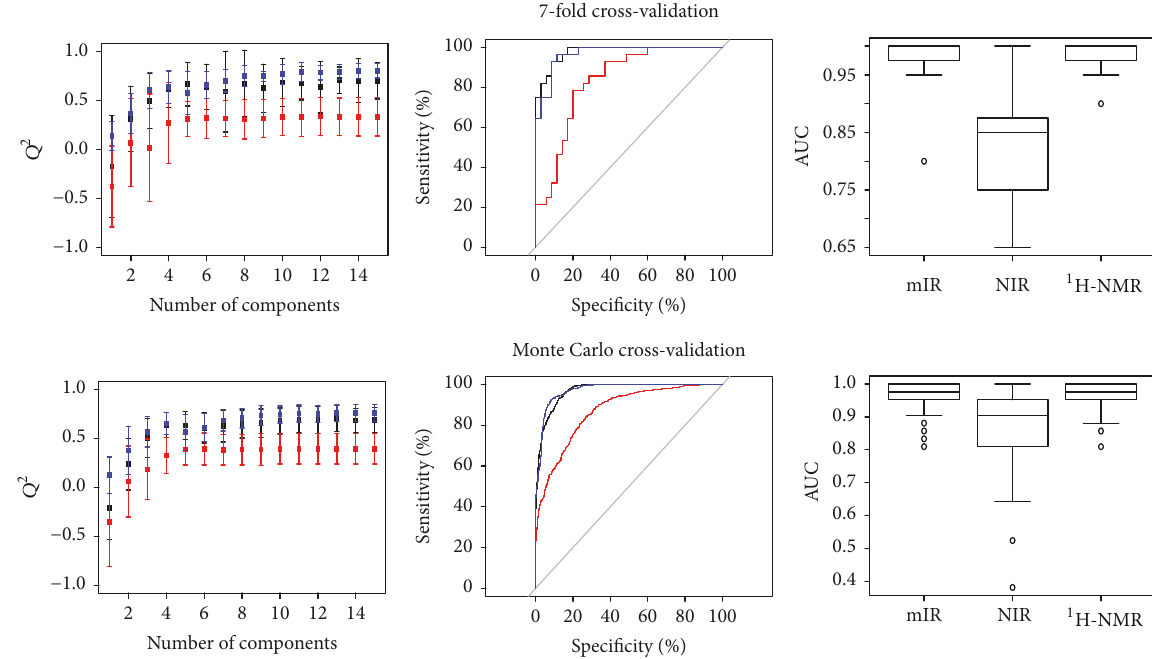
Figure 4: Results of discrimination by origin. In the coloured plots, blue is 1 H-NMR, black is ATR-mIR, and red is NIR. 𝑄 2 values as a function of the number of components in the model (left), ROC curves (center), and area under the ROC curve for all models represented as box plots (right). The upper panel shows results using a standard 7-fold cross-validation, while the lower panel shows results obtained with a 100-model Monte Carlo cross-validation.